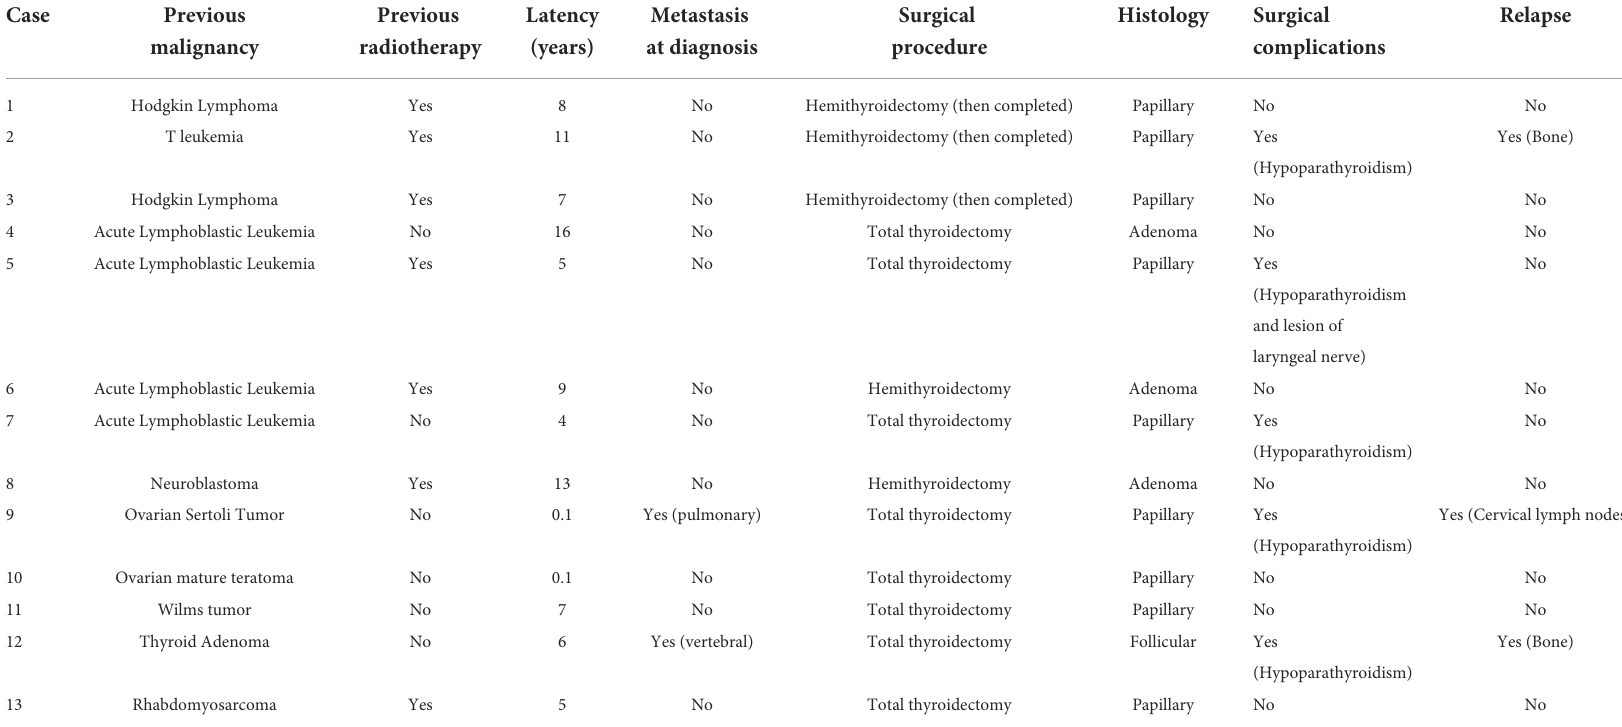
TABLE 1 Characteristics of patients with secondary thyroid